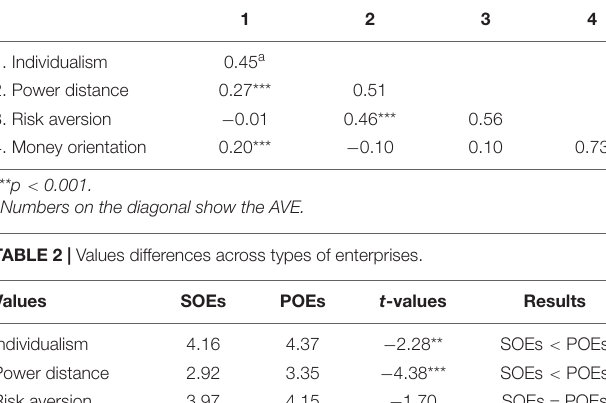
TABLE 1 | Correlation matrix.